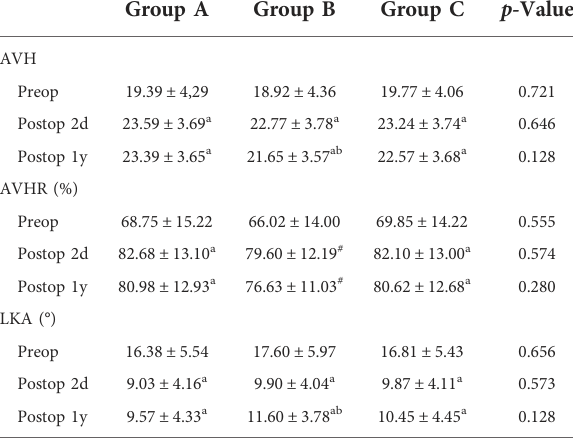
TABLE 2 Comparison of radiographic